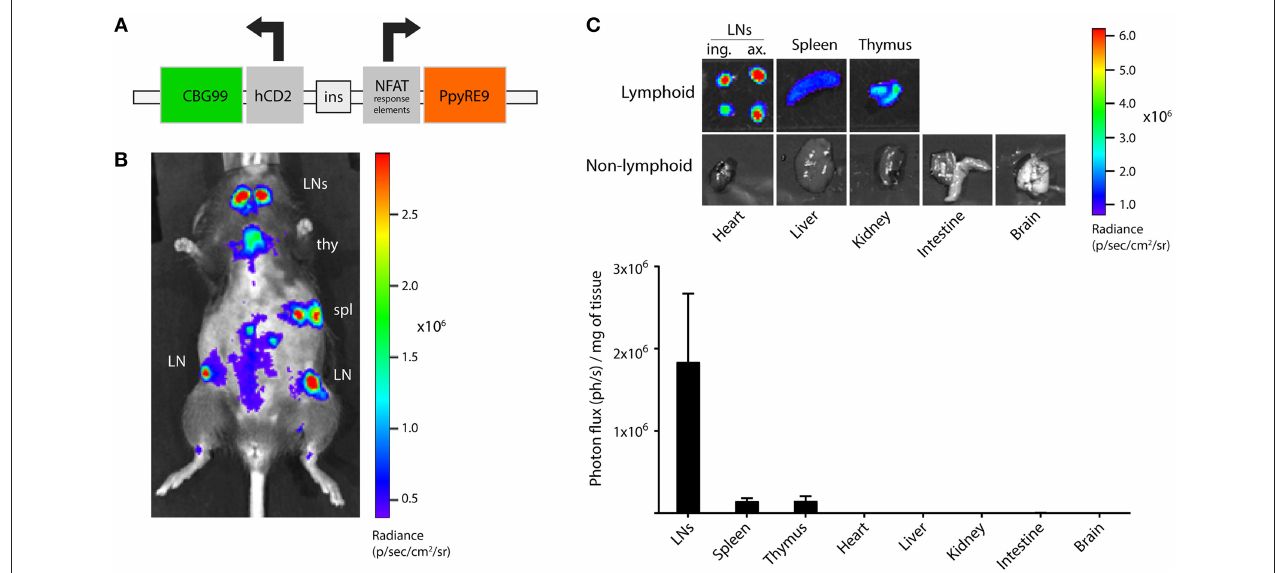
FIGURE 1 | Design and development of the dual-luciferase transgenic TbiLuc mouse. (A) Schematic overview of the dual-luciferase reporter bicistronic vector. NFAT, nuclear factor of activated T cells; CBG99, click beetle green luciferase 99; PpyRE9, Photinus pyralis red-emitting luciferase 9. (B) Bioluminescence measurement of a TbiLuc mouse using the D-luciferin substrate, showing strong constitutive CBG99 luciferase expression in lymphoid organs. Lymphoid organs are indicated: LN, lymph node; spl, spleen; thy, thymus. The abdomen is shaved to reduce signal absorption. (C) Representative images and quantification of luciferase signal in several lymphoid and non-lymphoid organs of TbiLuc mice ( n = 3, mean + SEM). LNs, lymph nodes; ing., inguinal; ax., axillary.